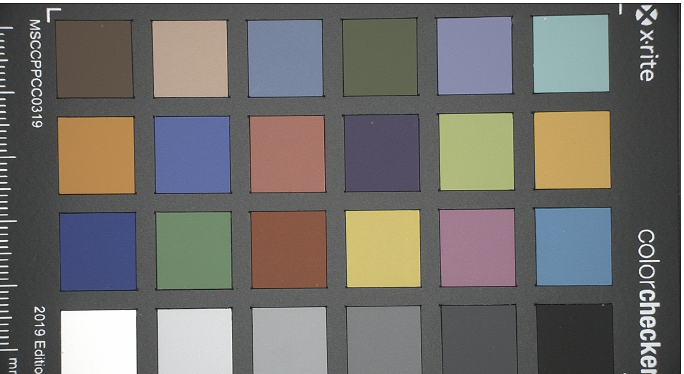
Figure 9. Macbeth chart.